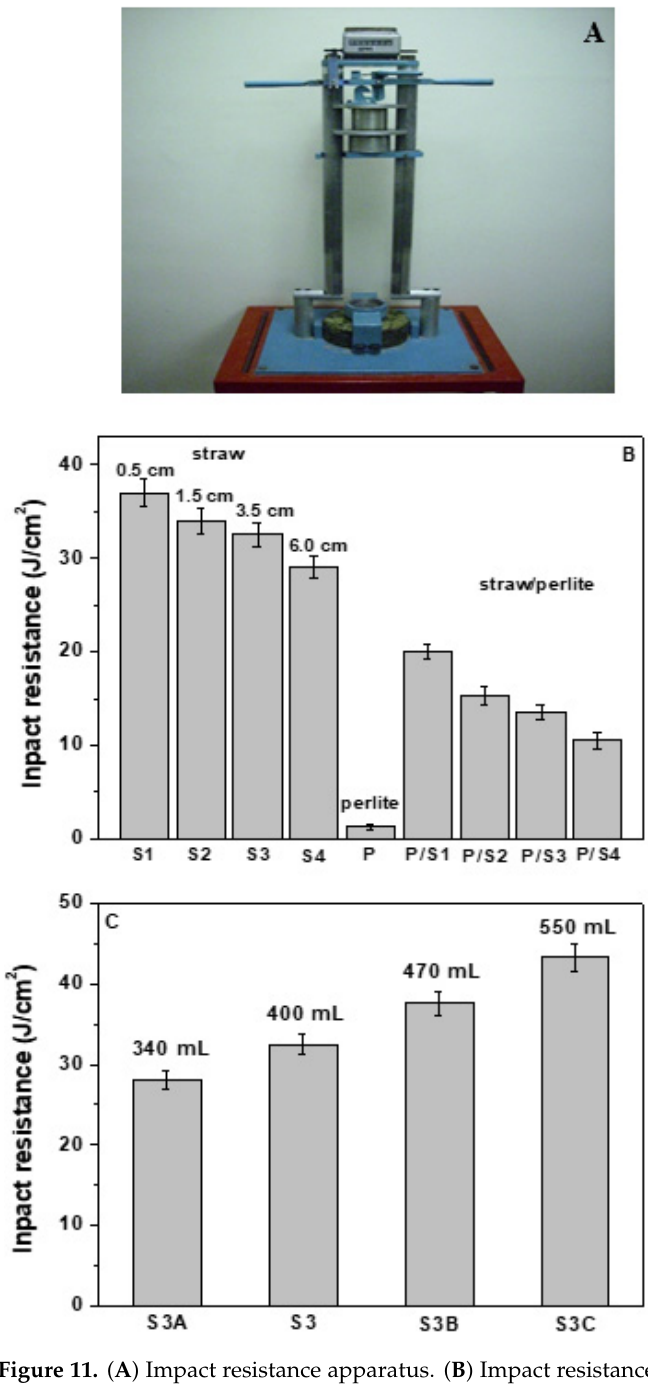
Figure 11. ( A ) Impact resistance apparatus. ( B ) Impact resistance of the specimens with the same volume of aggregates (400 mL). ( C ) Impact resistance of the S3 specimens with different volume of aggregates.